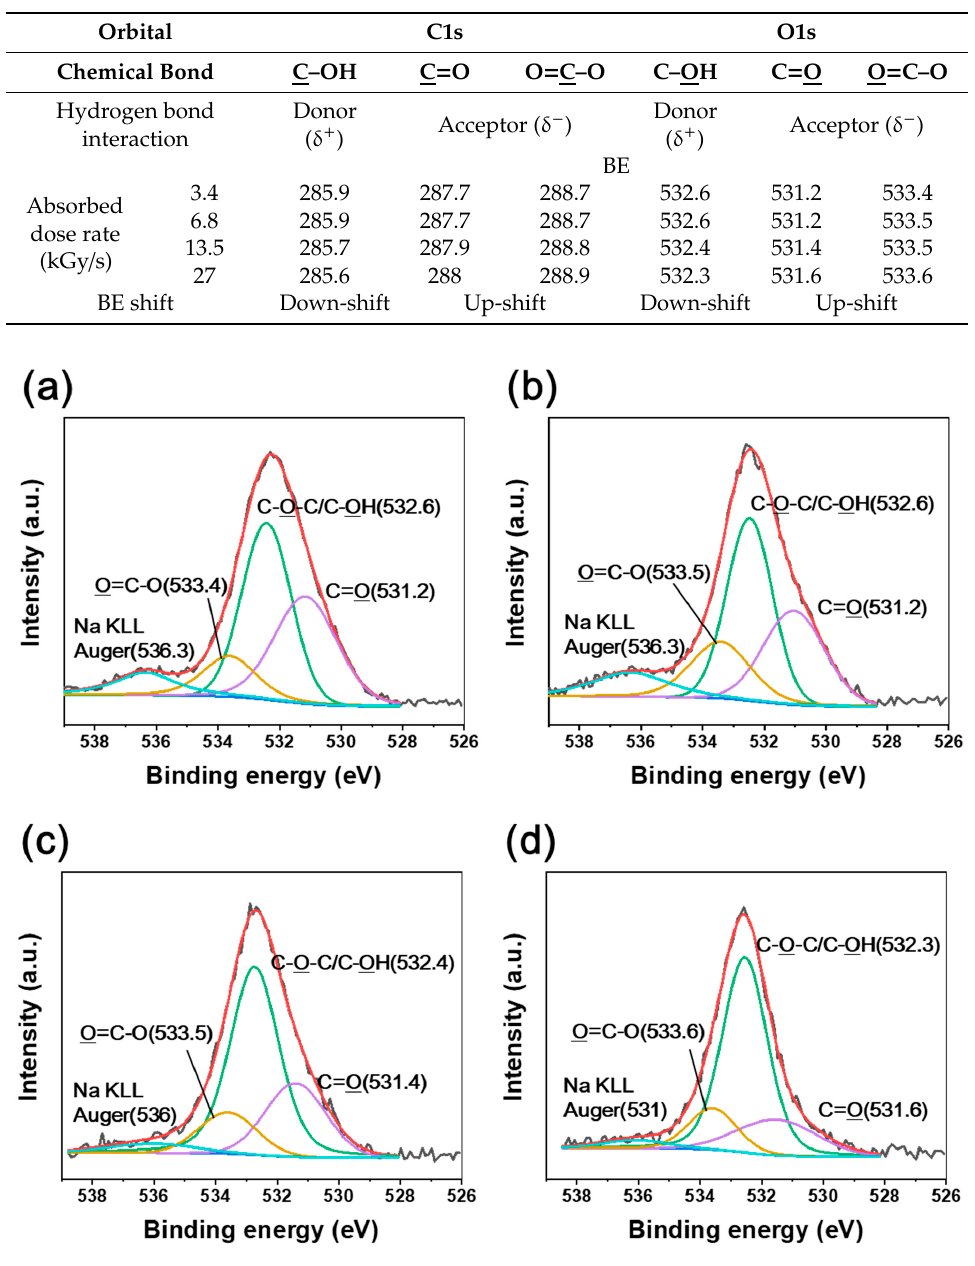
Figure 5. O1s XPS spectra of CFRTPs irradiated at ( a ) 3.4 kGy/s, ( b ) 6.8 kGy/s, ( c ) 13.5 kGy/s, and ( d ) 27 kGy/s absorbed dose rates.